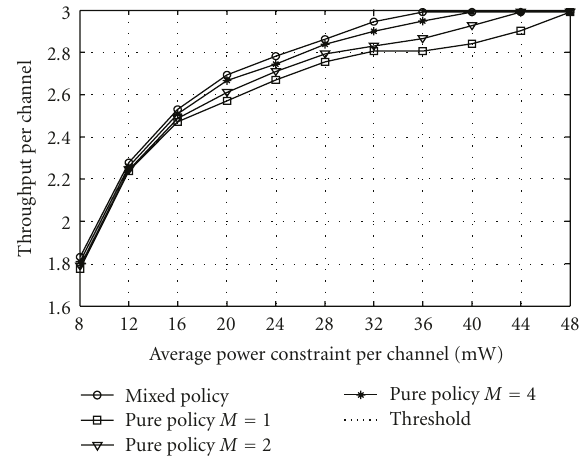
Figure 3: Performance comparison between centralized optimal mixed policies and pure policies under di ff erent average power